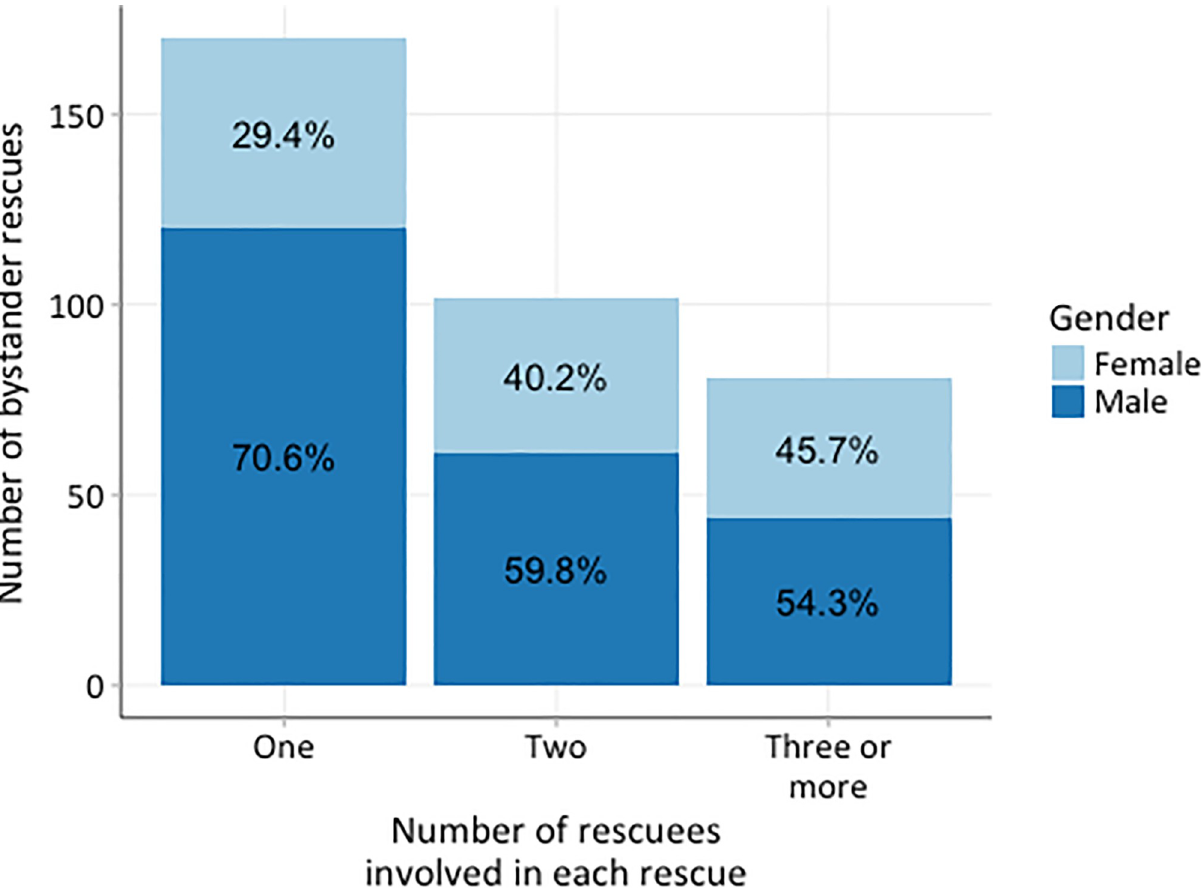
Fig 1. The number of rescuees involved in the bystanders’ most recent rescue. Gender differences are indicated based on the number of rescuees involved in the rescues.